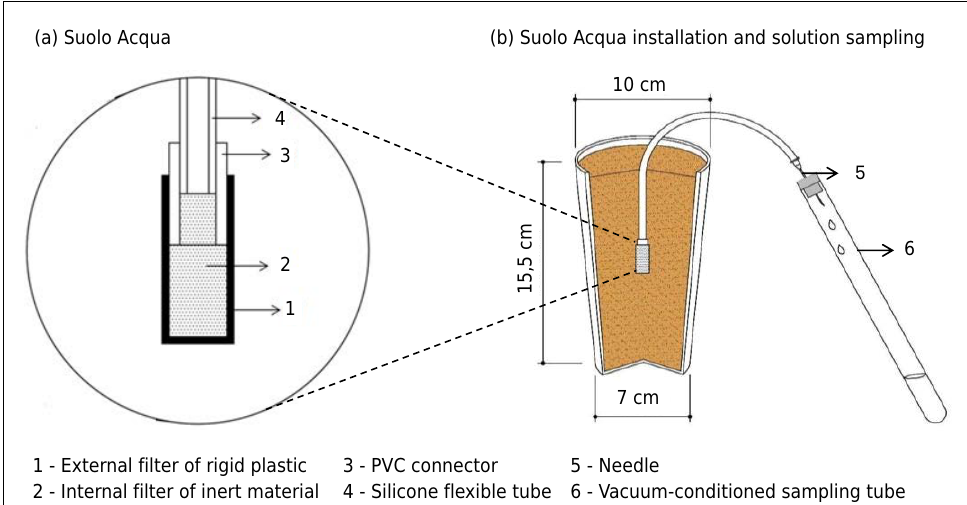
Figure 1. Schematic diagram of the Suolo Acqua sampler and its constituent parts (a) and Suolo Acqua installation and solution sampling procedure adopted for the pot used to incubate the soil samples